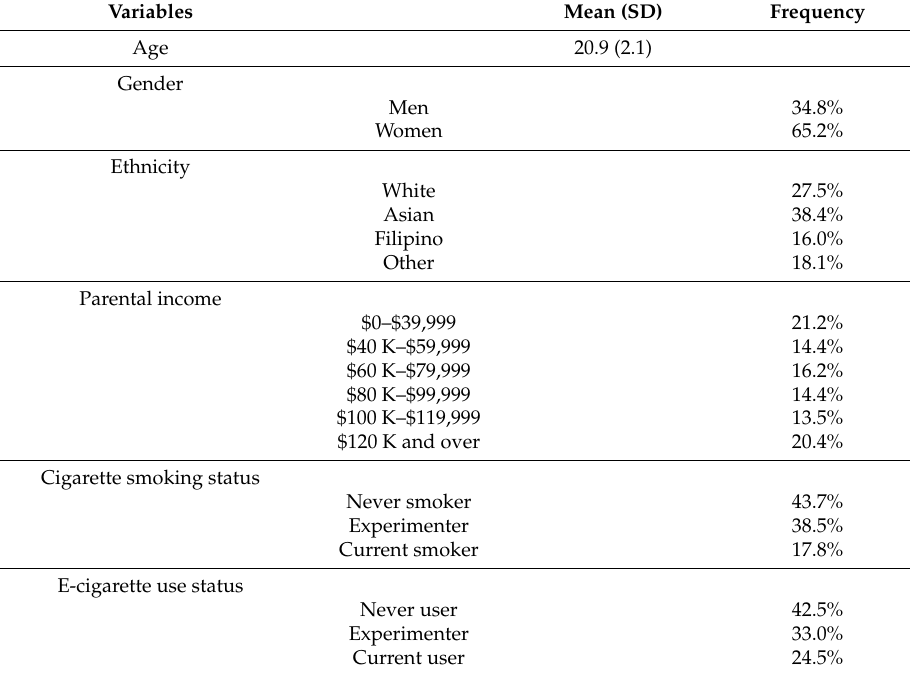
Table 1. Participant characteristics (N =